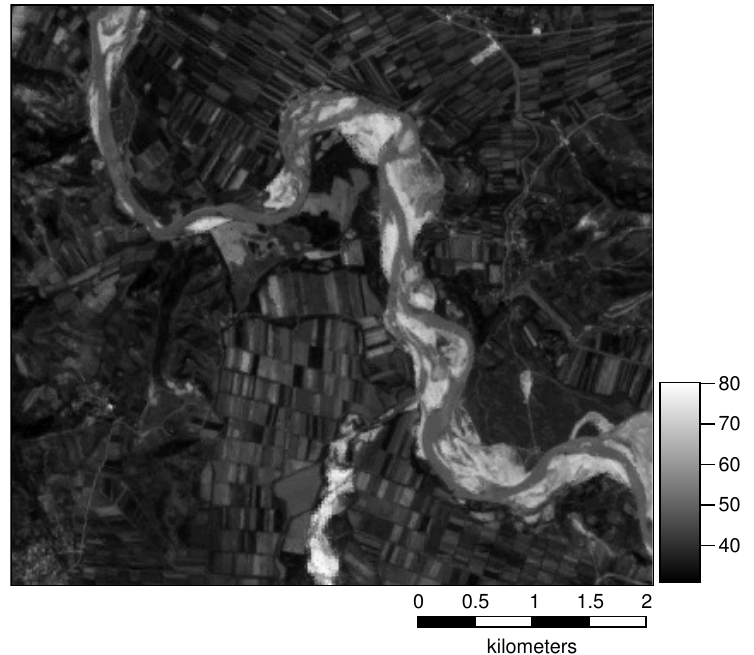
Figure 1. Example of the lightness component of the HSL color transformation of the Vjosë river, from LANDSAT 8